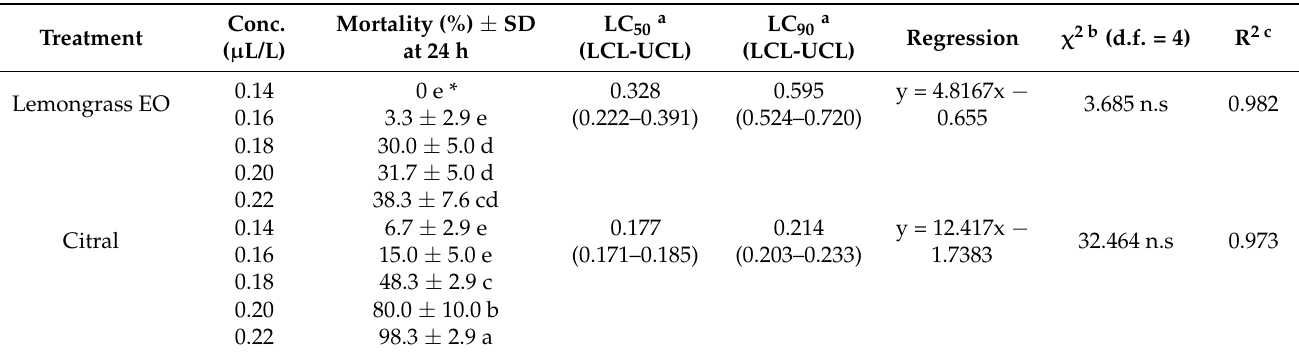
Table 2. Mortality rate at 24 h, lethal concentration for 50% and 90% mortality of lemongrass EO and citral against R. flaviceps